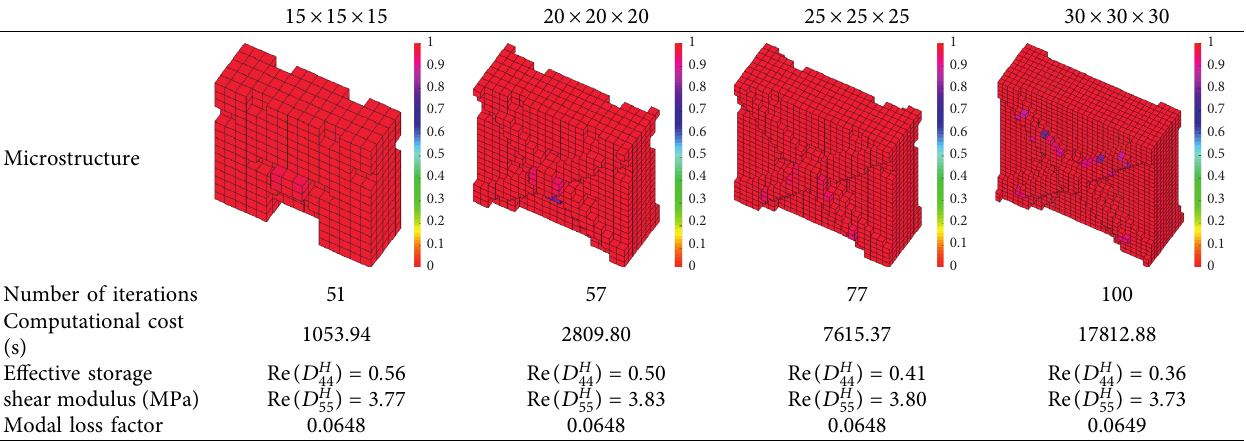
Table 4: Topological designs of viscoelastic damping material microstructures for four different meshes.